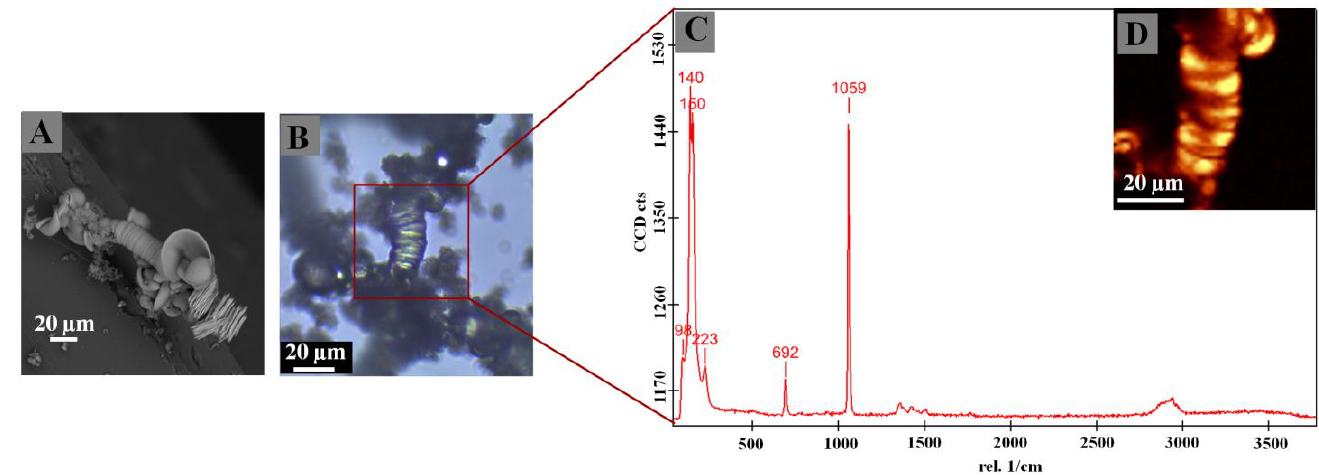
Figure 2. Representative image for the identification of the crystalline phase of BaCO 3 biomorphs synthesized at STP conditions at a concentration of DNA of 1.0 ng/µL through Raman spectroscopy: ( A ) SEM microphotograph; ( B ) optical image; ( C ) Raman spectrum; ( D ) mapping of biomorph.